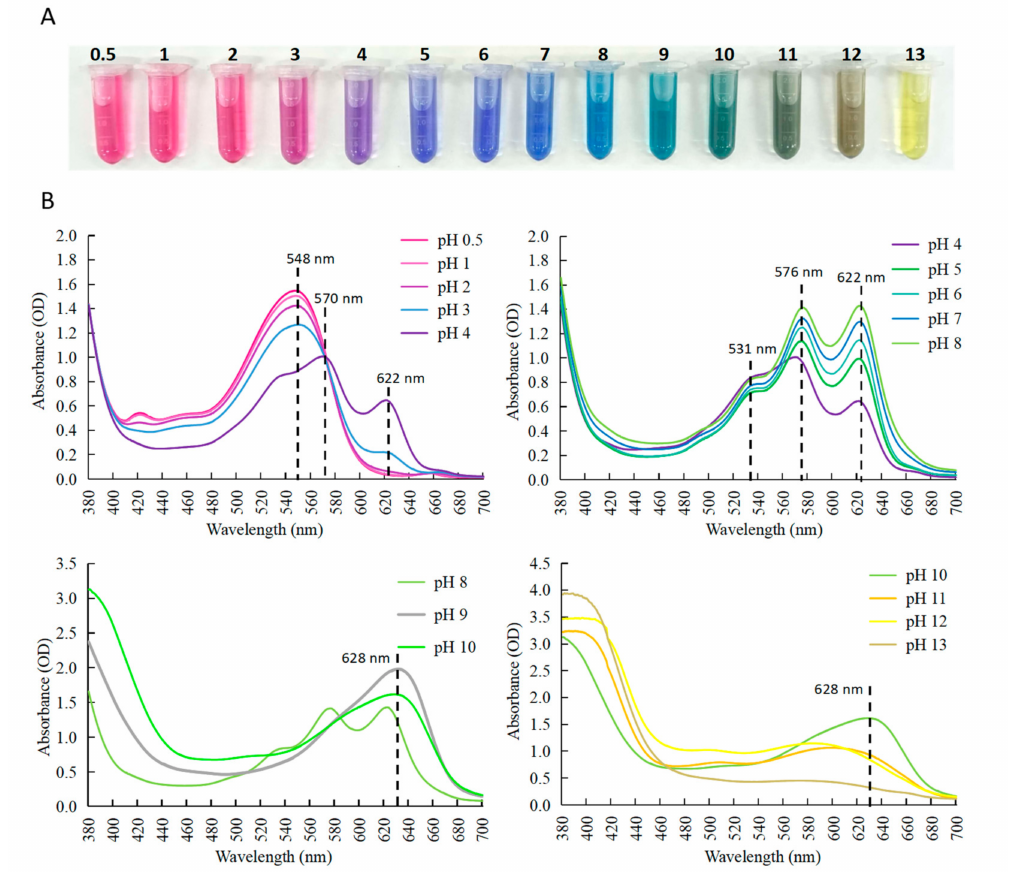
Figure 2. Color and absorption spectra of CTAEs at different pHs. ( A ) Color of CTAEs from pH 0.5 to 13. ( B ) Absorption spectra of CTAEs from pH 0.5 to 13. The absorption peaks are highlighted by vertical lines with values of λ max